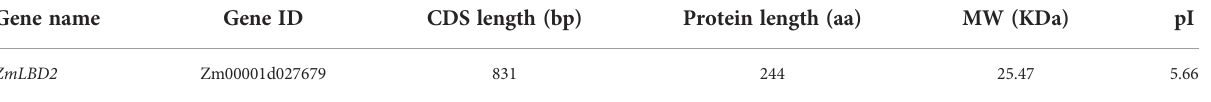
TABLE 1 The physiochemical characteristics of maize ZmLBD2